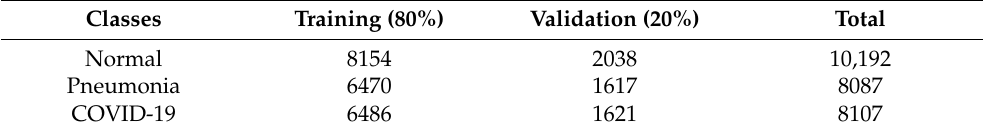
Table 3. Details of Train–test class-wise distribution of datasets after the augmentation